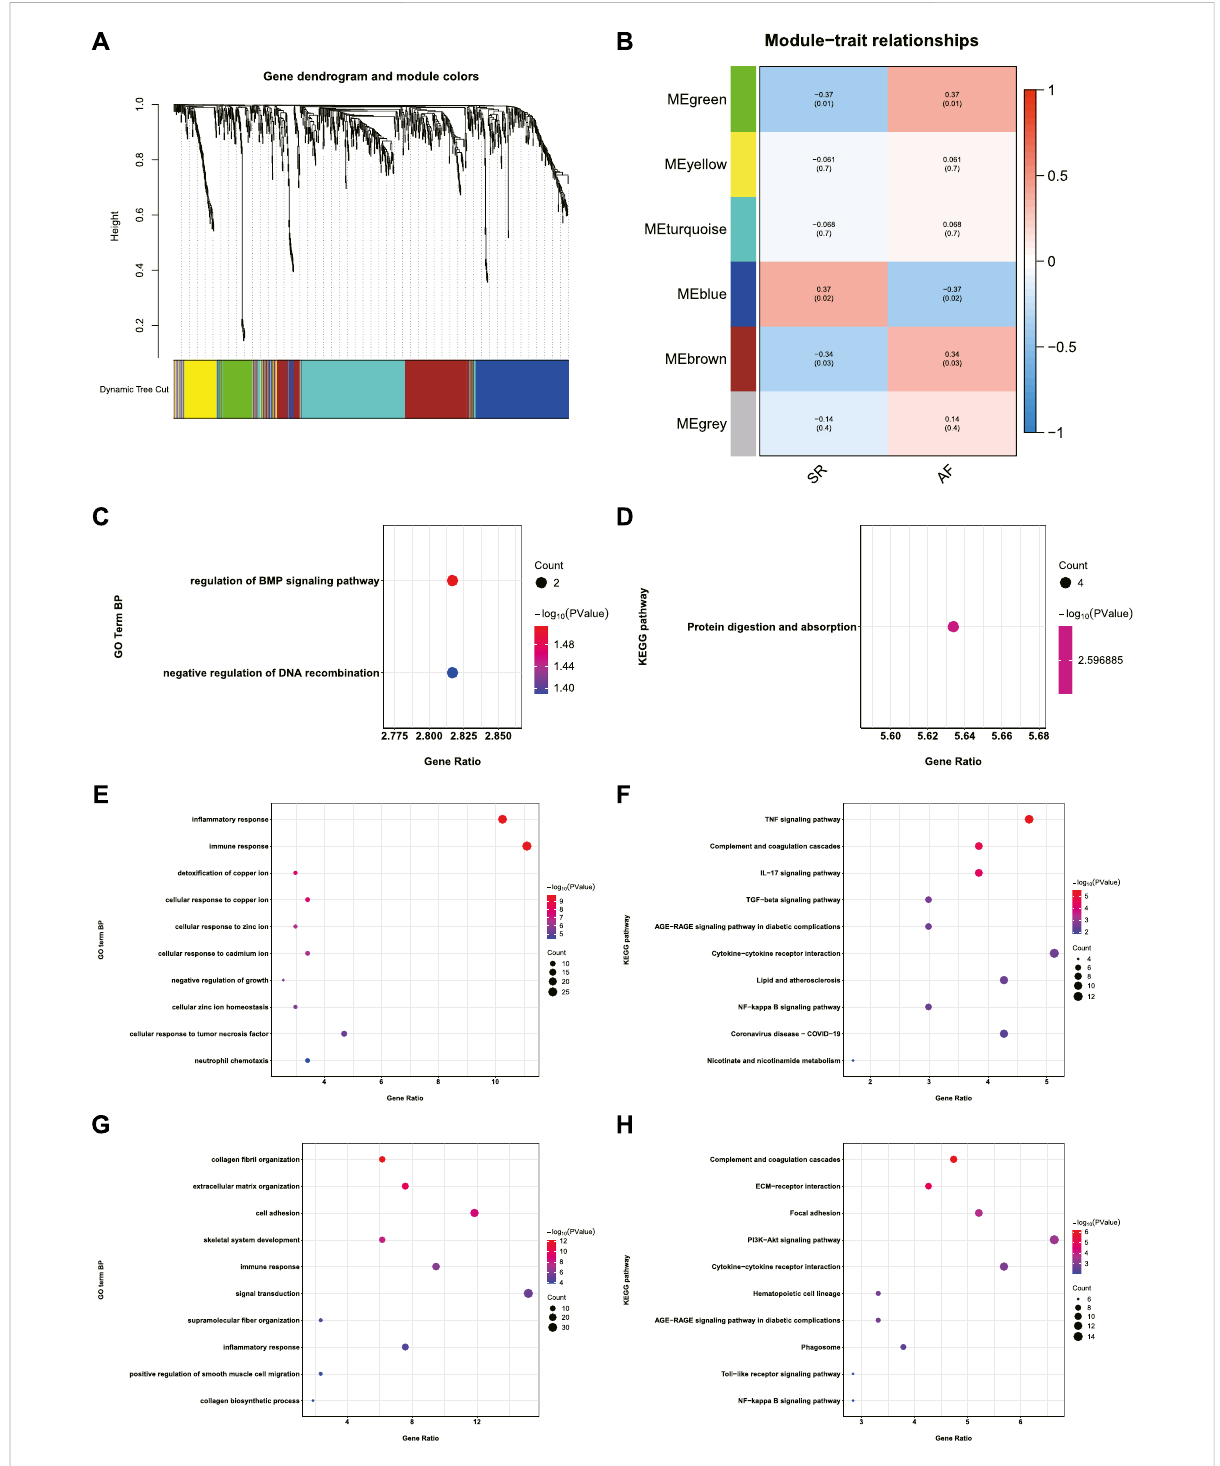
FIGURE 2 ConstructionofAF-relatedgeneco-expressionnetworkandtheenrichmentanalysisofgenesintheAF-relatedgenemodules. (A) Dendrogram and clustering for identi fi cation of gene co-expression modules. (B) Correlation analysis of gene co-expression modules with AF. The numbers above brackets were correlation coef fi cients and the numbers in brackets were p values. (C,D) GO-BP and KEGG enrichment analysis of genes in green module. (E,F) GO-BP and KEGG enrichment analysis of genes in blue module. (G,H) GO-BP and KEGG enrichment analysis of genes in brown module. AF: atrial fi brillation, GO-BP: gene ontology biological process, KEGG: Kyoto Encyclopedia of Genes and